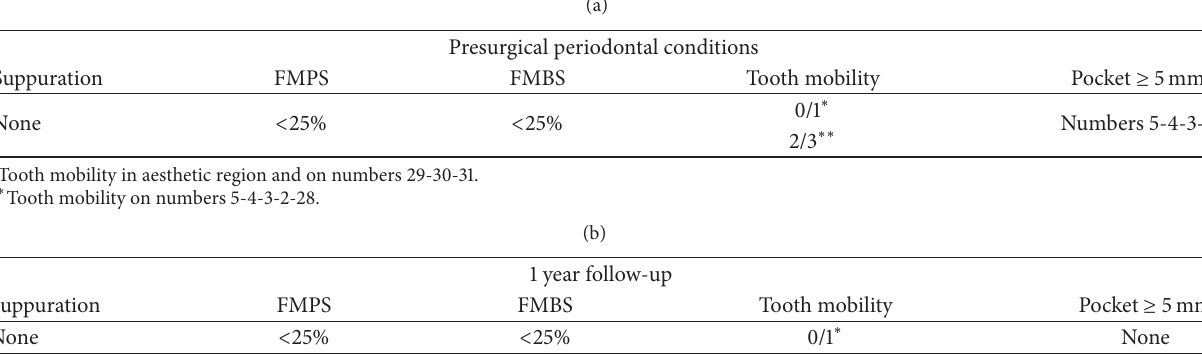
Table 2: Periodontal conditions schematic overview at presurgical time and after 1 year